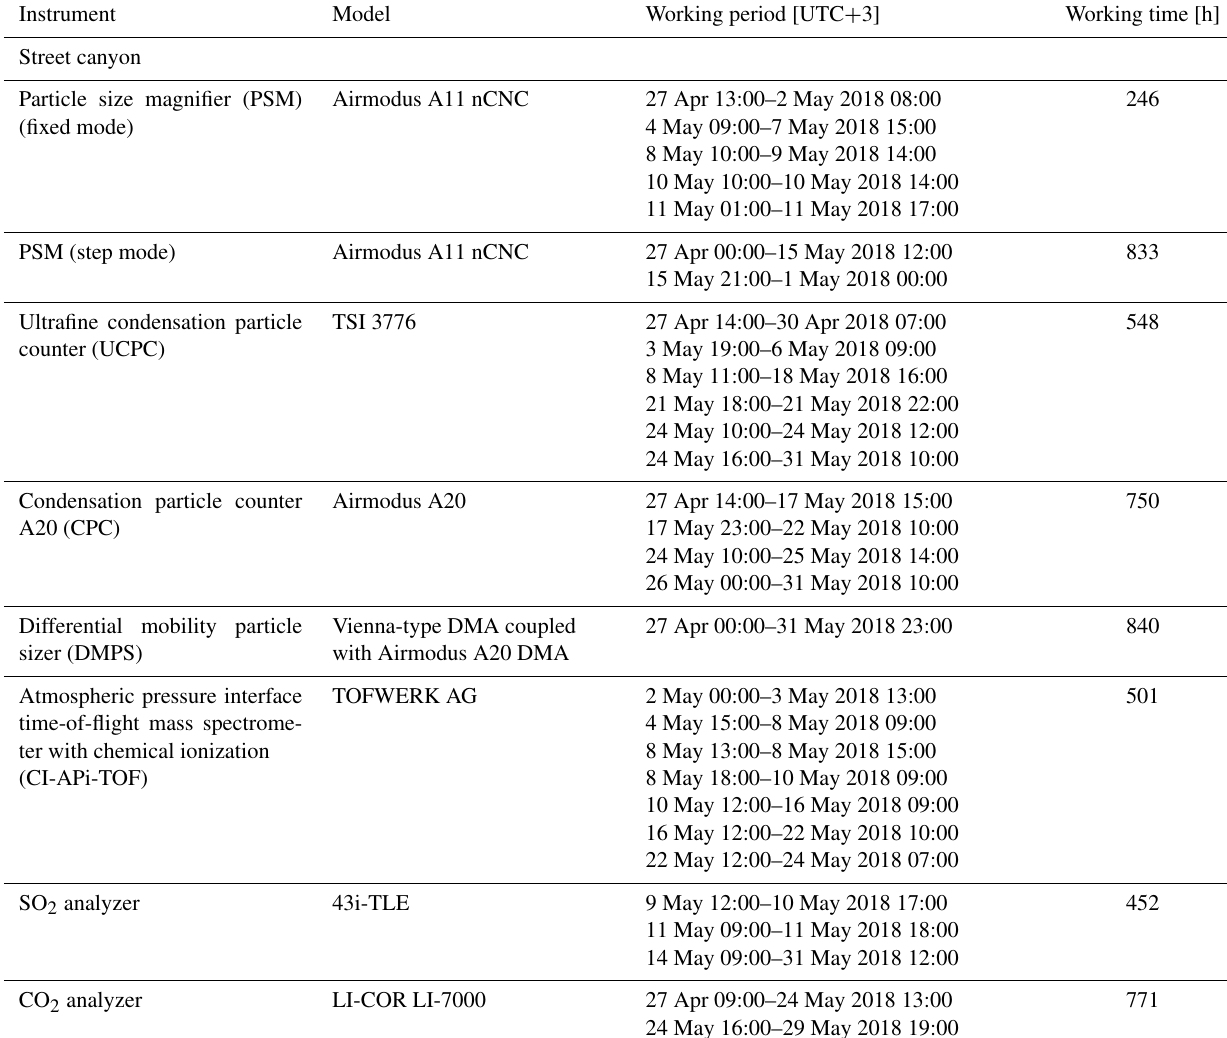
Table A1. Working time of instruments used during the campaign. Instrument Street